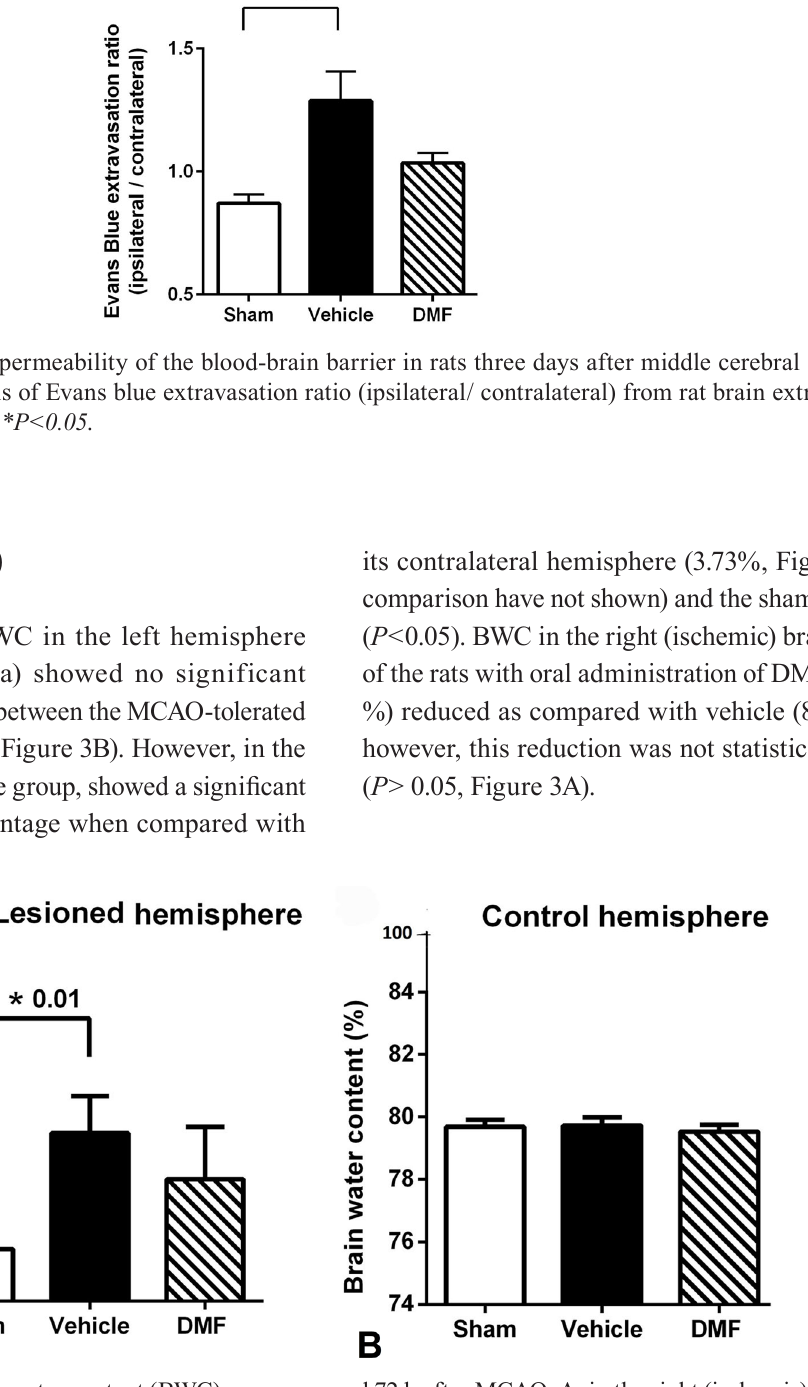
FIGURE 3 - Percentage of brain water content (BWC) was measured 72 h after MCAO. A, in the right (ischemic) hemisphere and B, left (control) hemisphere by the wet/dry weight method; Data are expressed in percentage as mean ± SD (n = 5 per group). * P<0.05